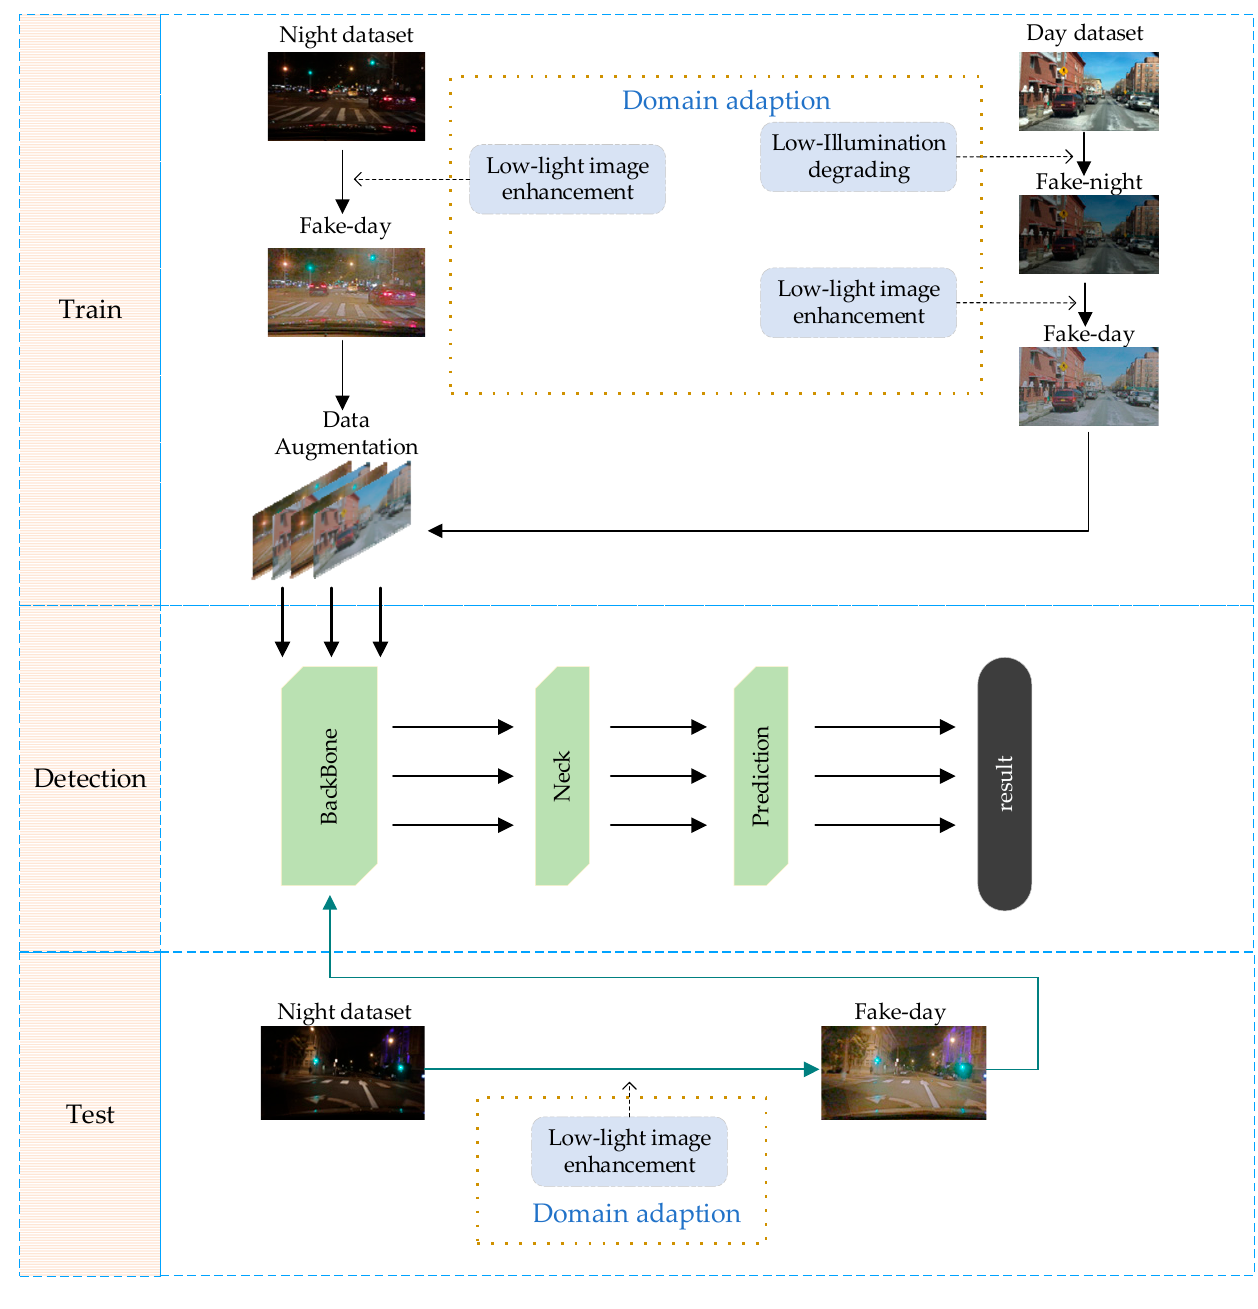
Figure 3. General training and testing framework for algorithms.